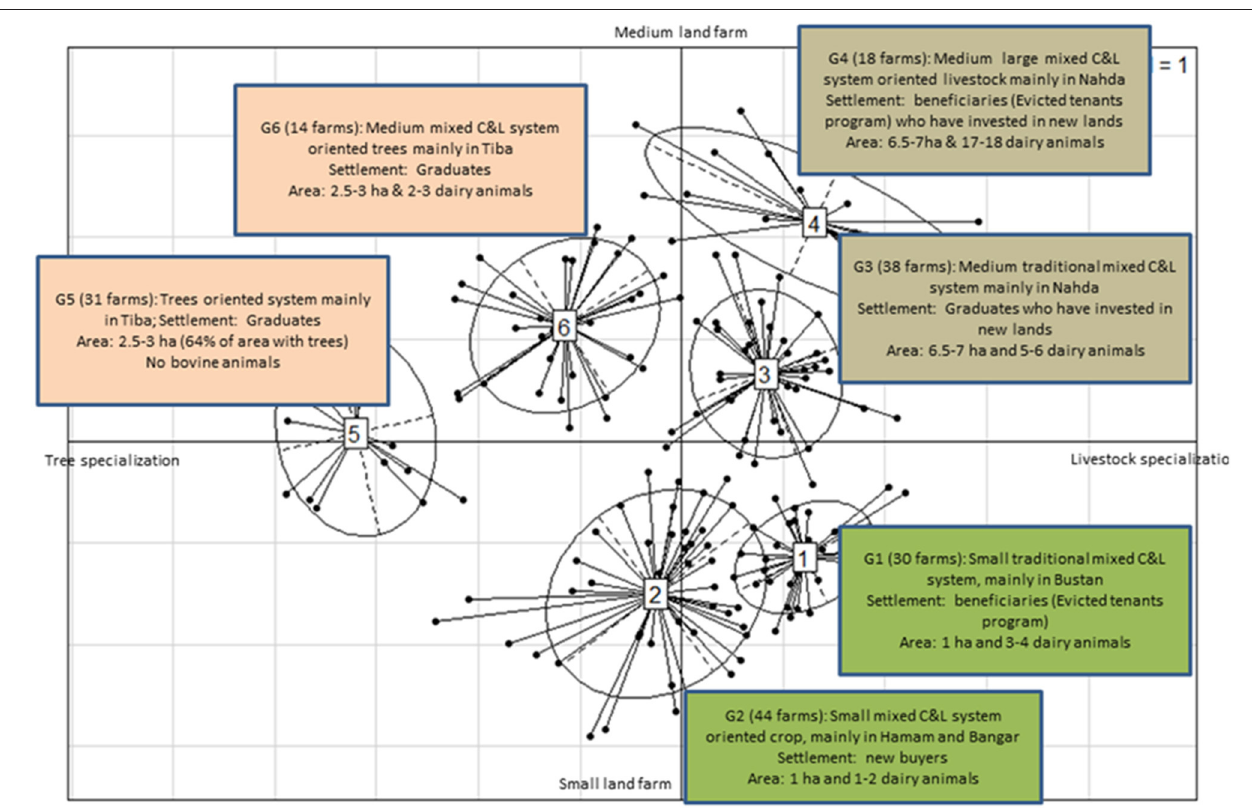
FIGURE 3 | Representation of the six family farming systems and their main characteristics in the first factorial plan (F1*F2). (1) C&L for integrated Crop and Livestock systems; (2) Each circle represents the confidence interval at 95% and the lines are the distance between each individuals and the center of gravity of each cluster.